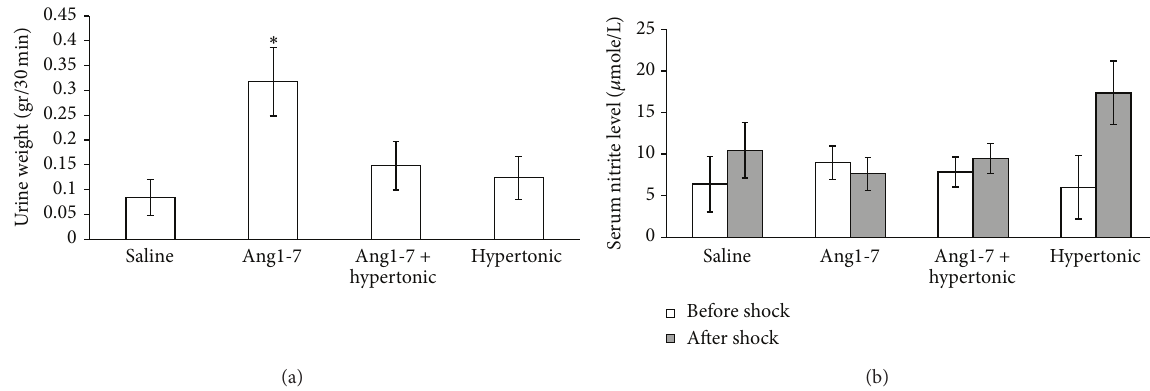
Figure 2: (a) Urine weight response to saline, Ang1-7, Ang1-7 + hypertonic saline, and hypertonic saline alone administration. (b) Serum nitrite level before hemorrhagic shock and 30 minutes after administration of saline, Ang1-7, Ang1-7 + hypertonic saline, and hypertonic saline alone from the end of hemorrhagic shock. Data are shown as mean ± SEM. Ang1-7, Angiotensin 1-7; ∗ , means significant difference between Ang1-7 and saline. 𝑃 value was derived from